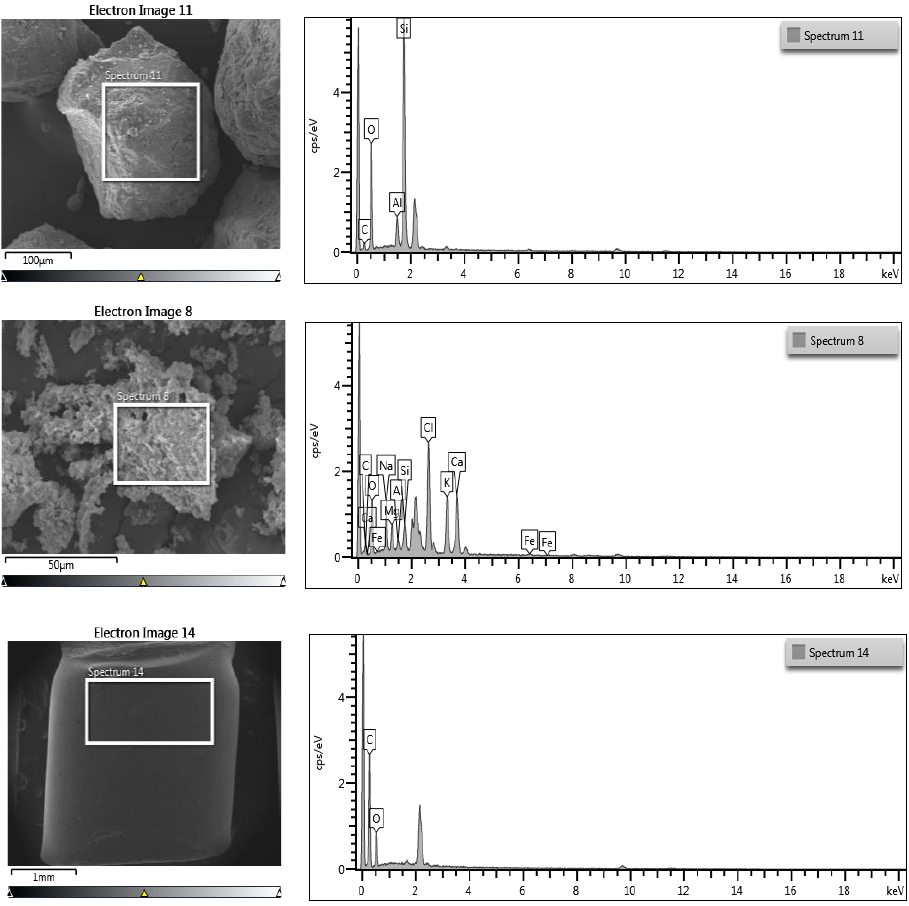
Figure 4. Microstructural characterization and chemical composition of raw materials.